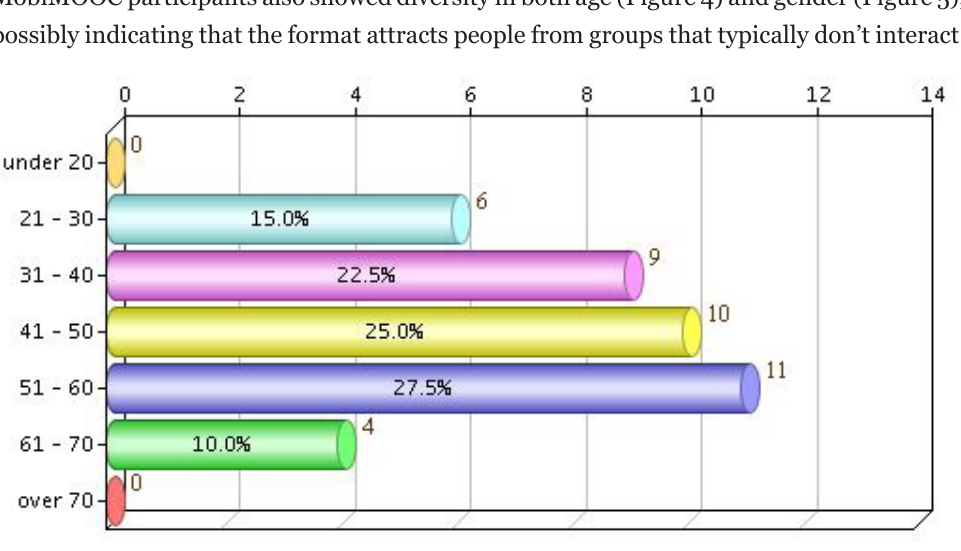
Figure 4 . What is your age group? ( N = 40).